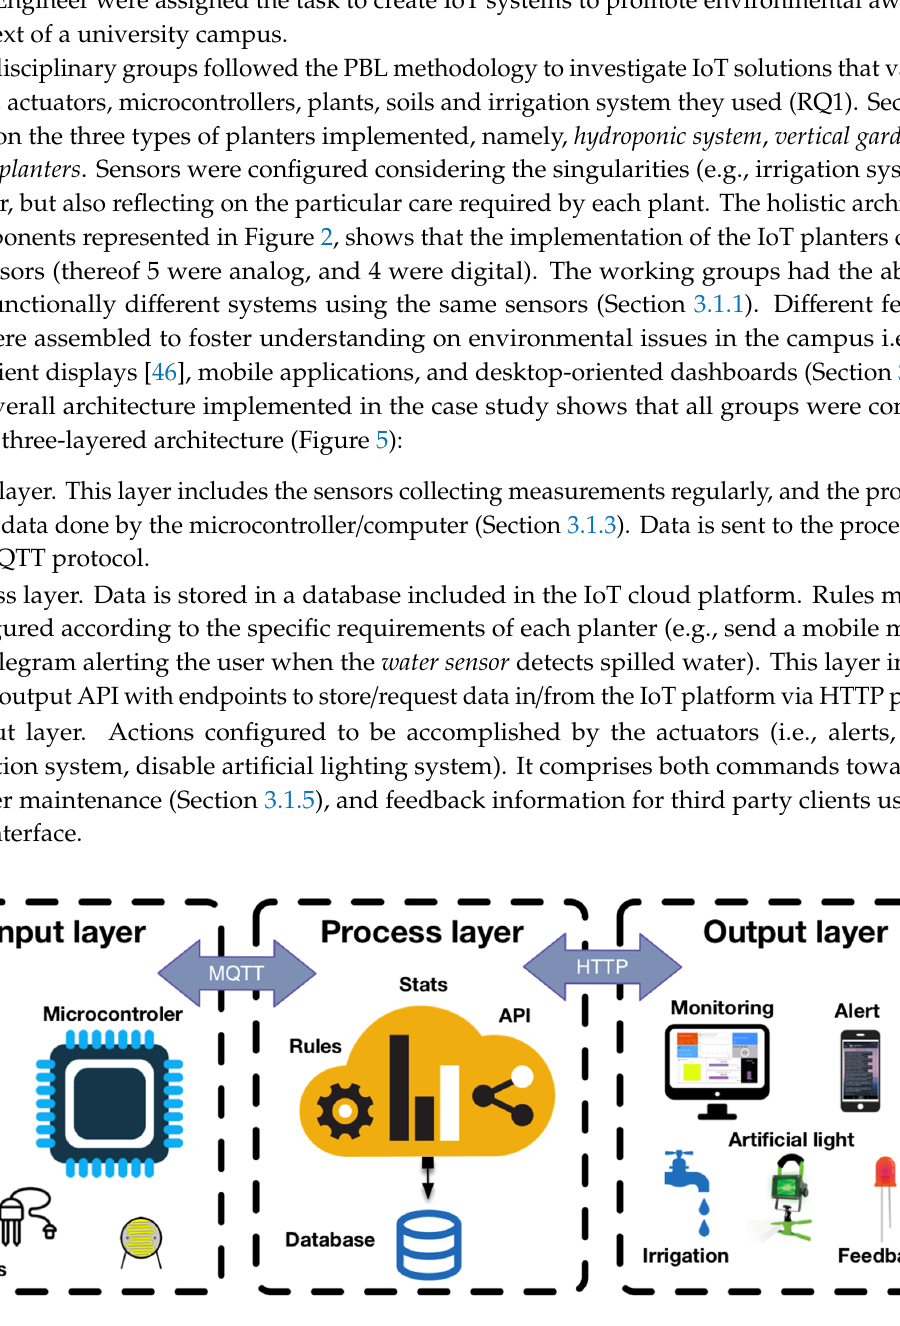
Figure 5. Frequently implemented three-layered architecture in IoT ecosystems.